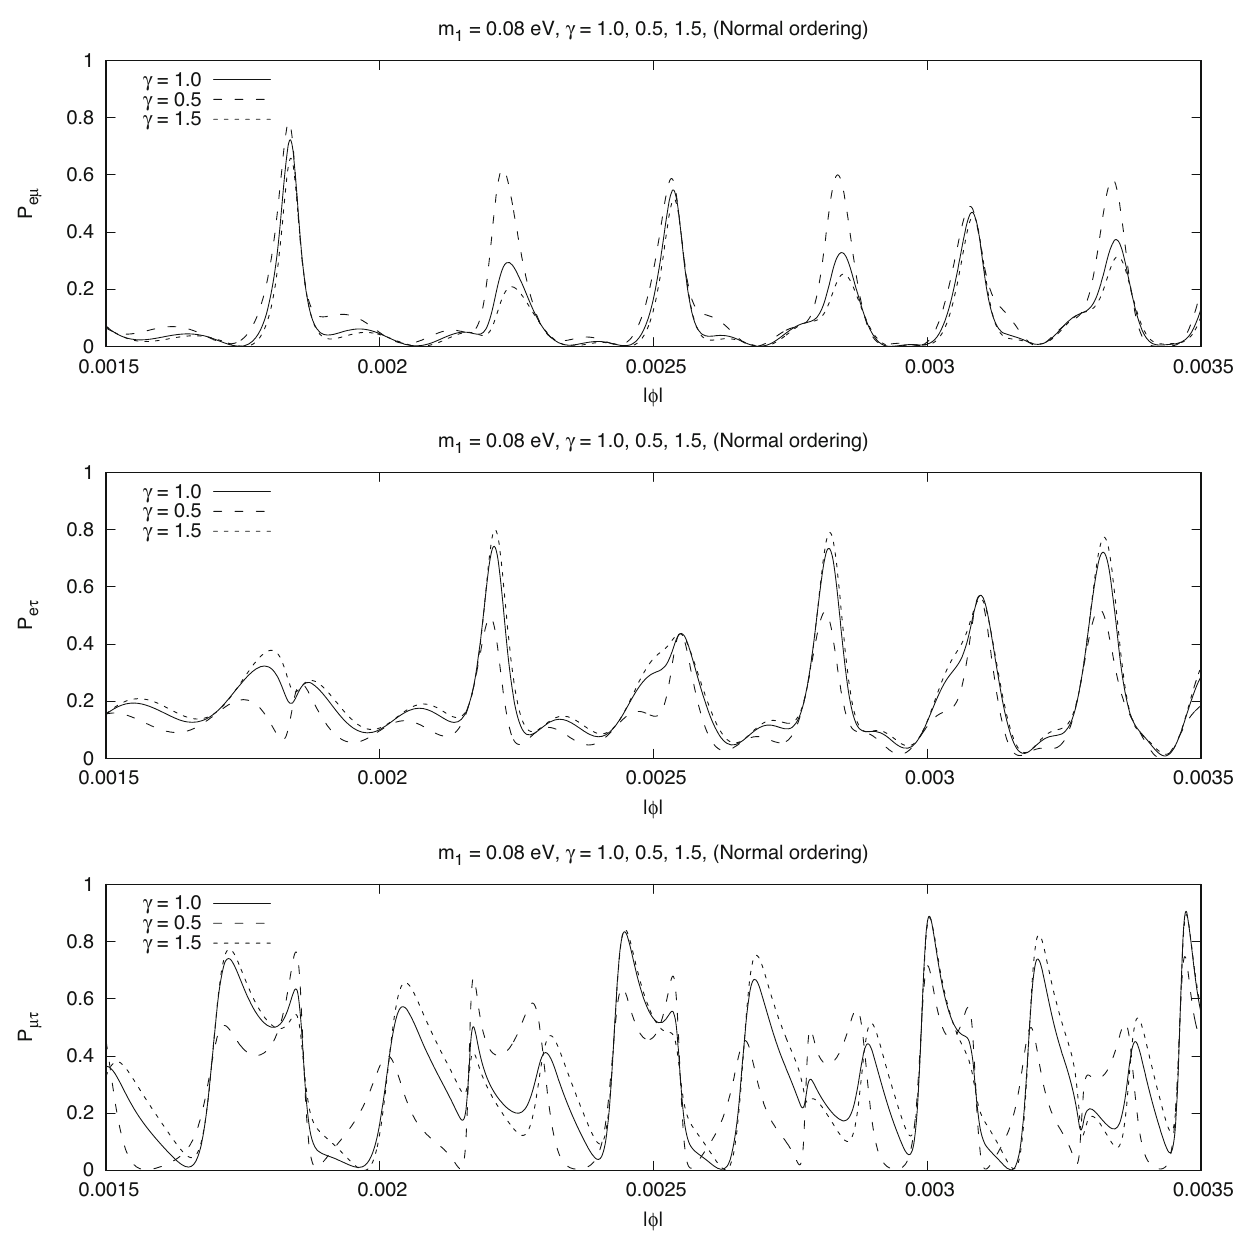
Fig. 9 Oscillationprobabilityforthethreeflavorcaseinnormalhierar- chy with m 1 = 0 . 08 eV. Top panel: probability of ν e → ν μ conversion for γ = 1 . 0 (solid line), γ = 0 . 5 (dashed line), γ = 1 . 5 (dotted line). Mid panel: probability of ν e → ν τ conversion for γ = 1 . 0 (solid line), γ = 0 . 5 (dashed line), γ = 1 . 5 (dotted line). Bottom panel: probability